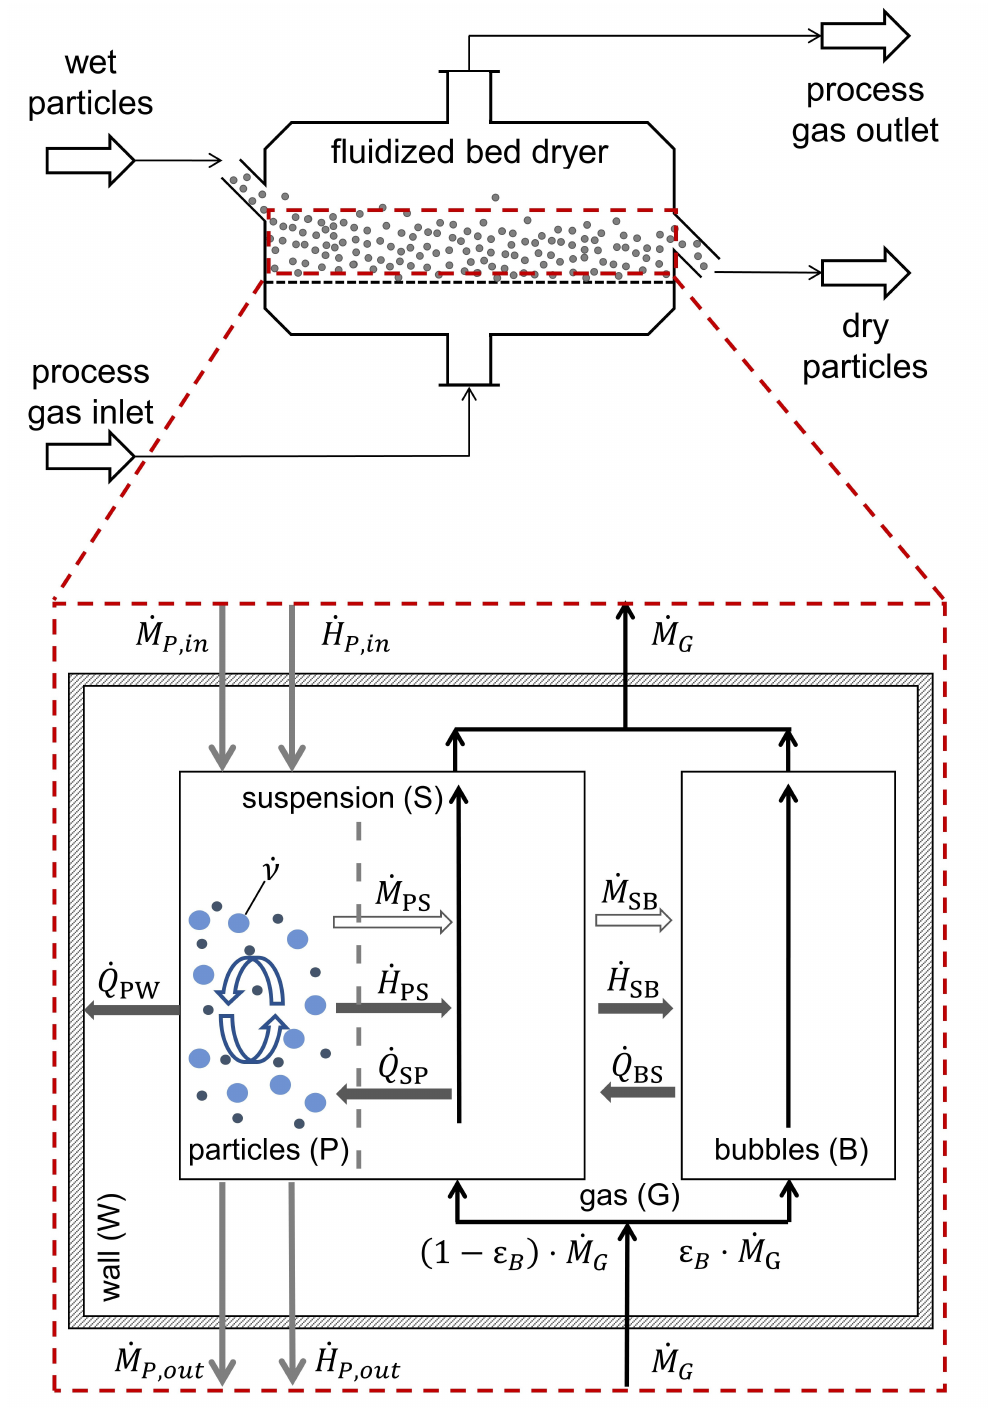
Figure 1. Schematic of the fluidized bed drying model; including the distinguished phases, namely the ideally mixed particle phase (P) and the plug flow suspension (S) and bubble (B) phase, as well as the respective mass ( ˙ M ), enthalpy ( ˙ H ) and heat flows ( ˙ Q